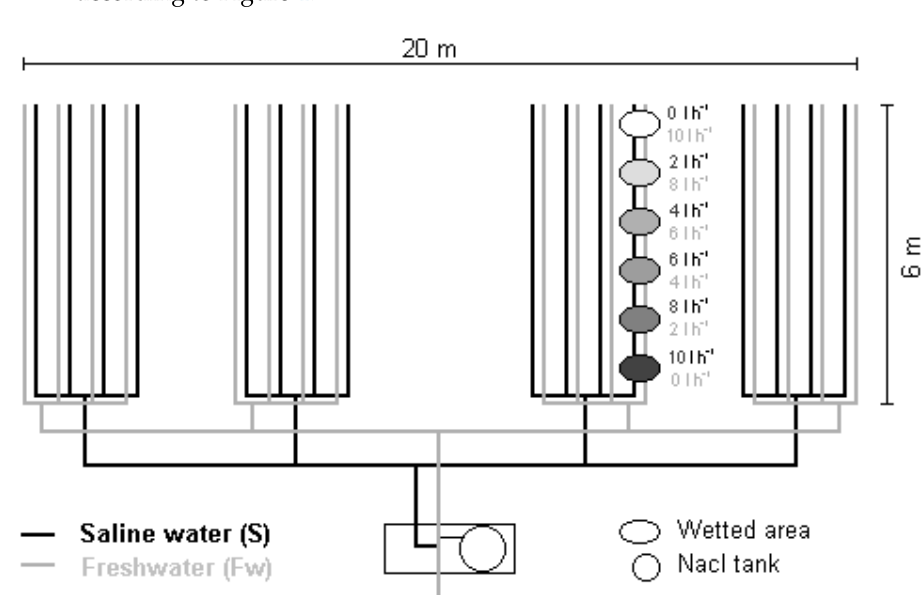
Figure 4. Layout of the double emitter source DES. The emitters on the two-coupled lines have different discharges, but their cumulative discharge at each trickling point was constant along the lateral (10 L h − 1 for each trickling point). However, the varying discharges of the emitters provoked varying salt concentrations of each trickling point along the lateral, and the darkness represents increasing salinity.